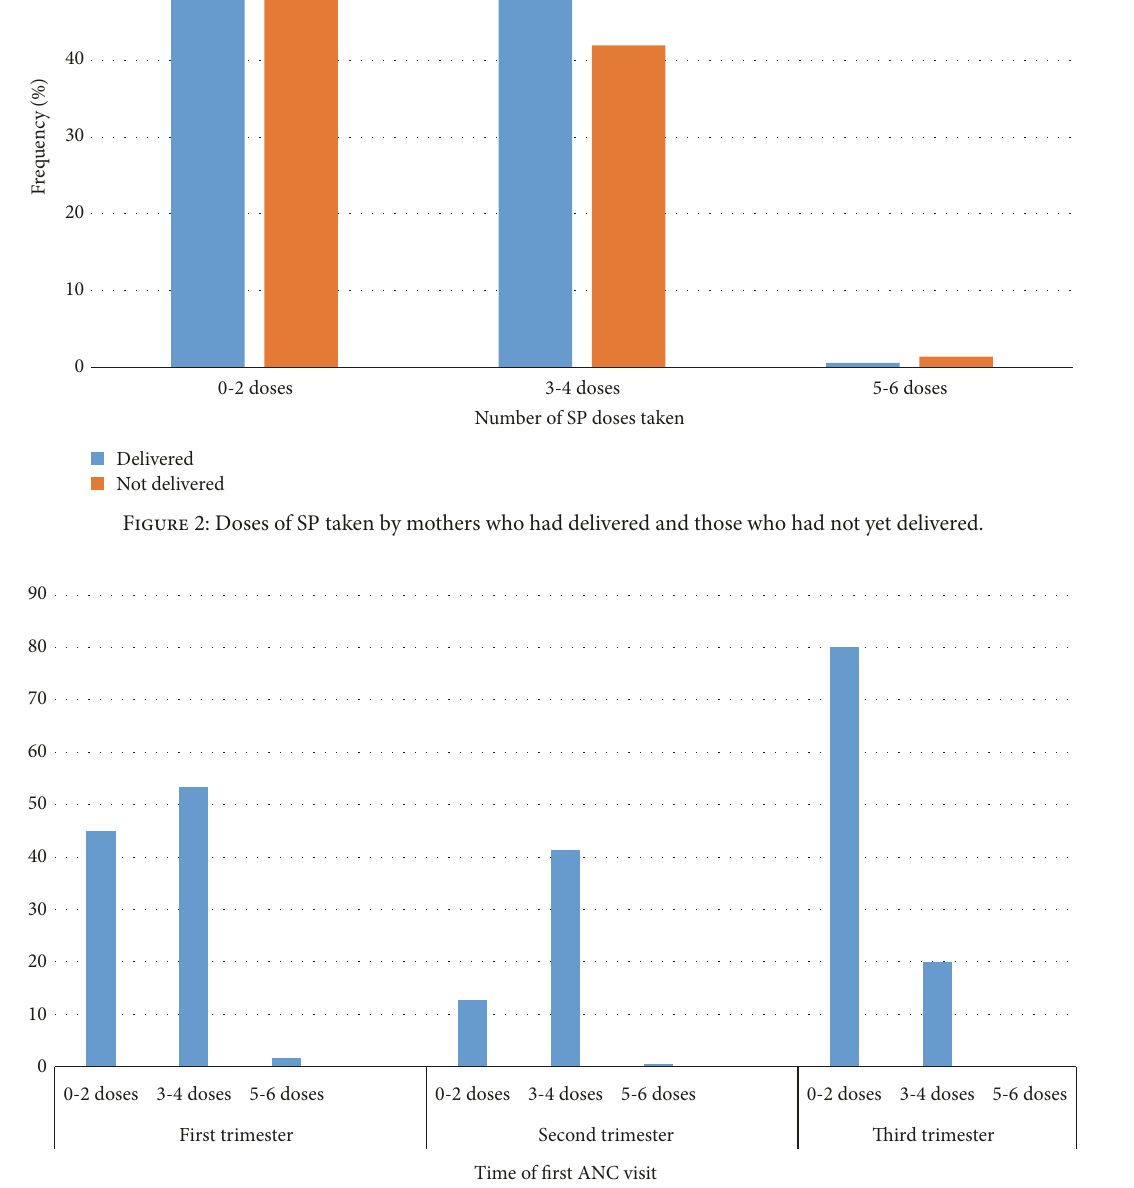
Figure 3: Time of first ANC visit and number of SP doses